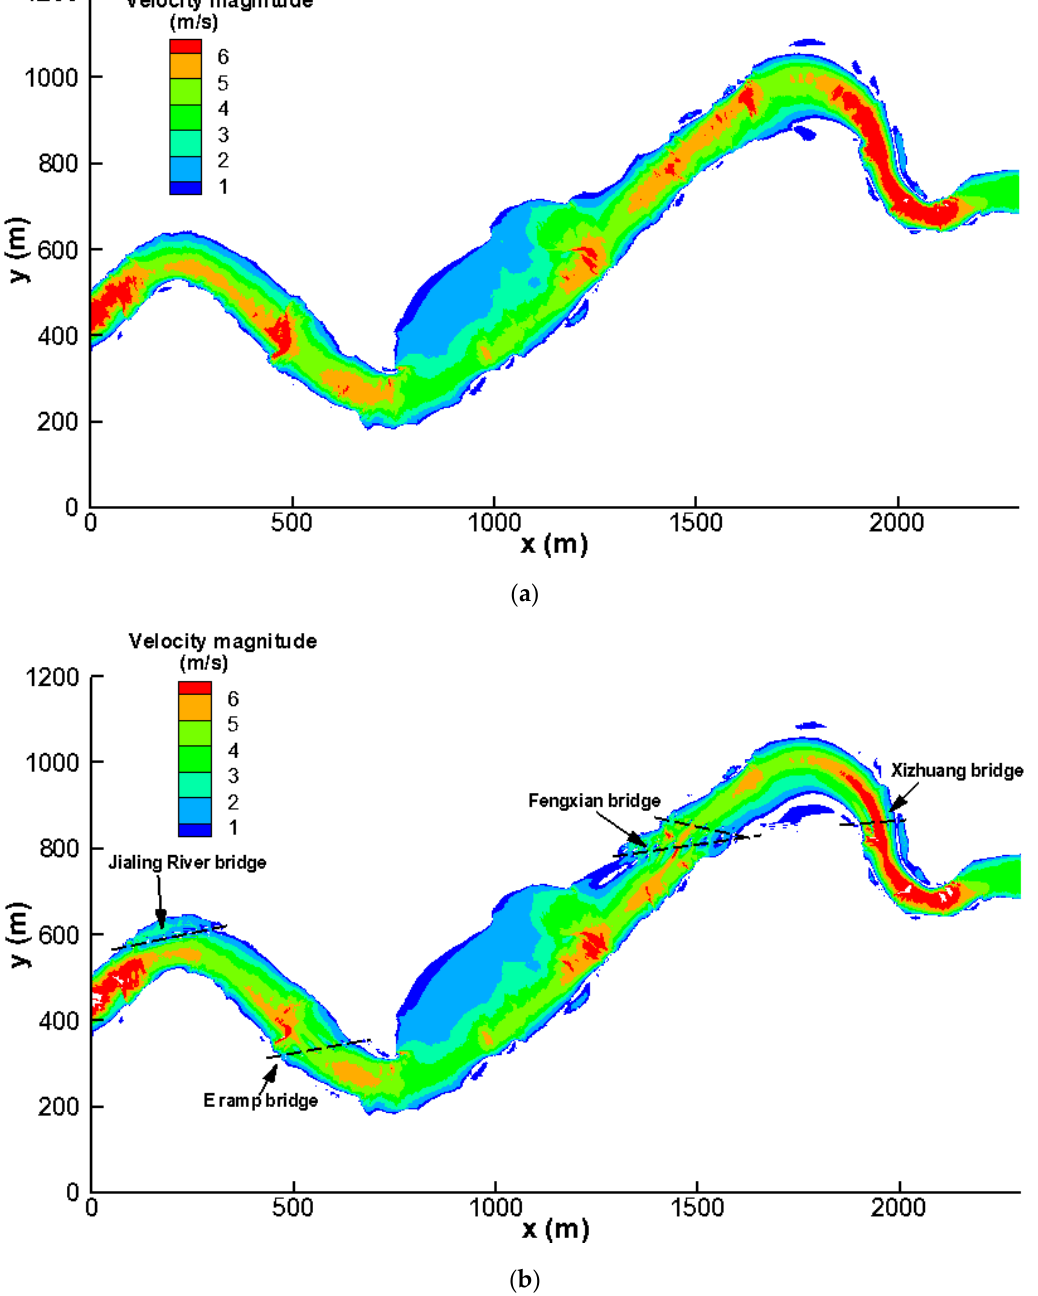
Figure 10. Distributions of the computed velocity magnitude for 100-year flood conditions. ( a ) Results without bridge piers, and ( b ) results with bridge piers.